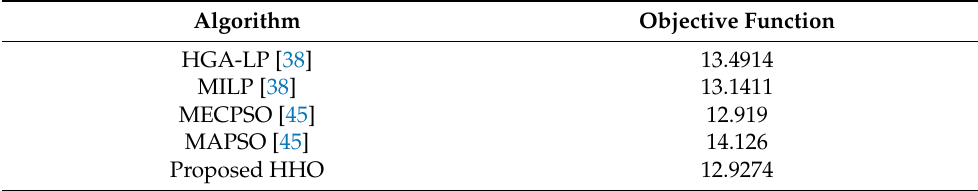
Table 9. Comparison of HHO with other